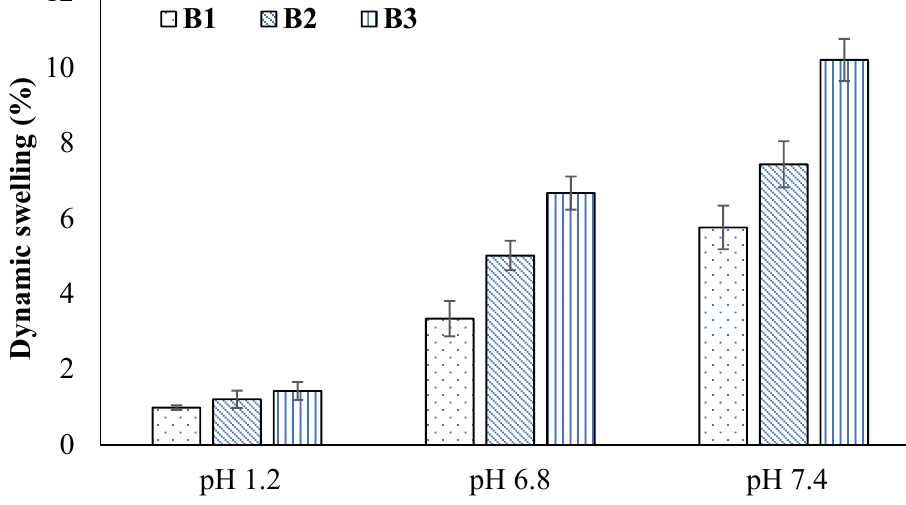
Figure 4. Effect of AA on dynamic swelling of 5-FULH.